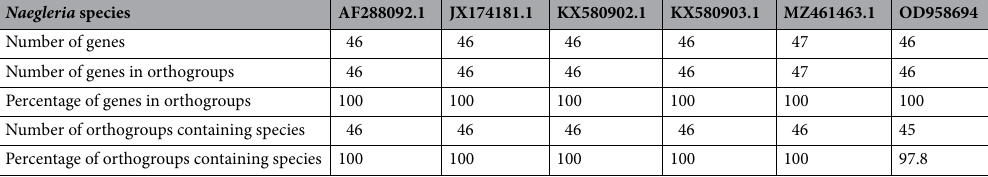
Table 4. Statistics per species; orthogroups statistics for each Naegleria species.